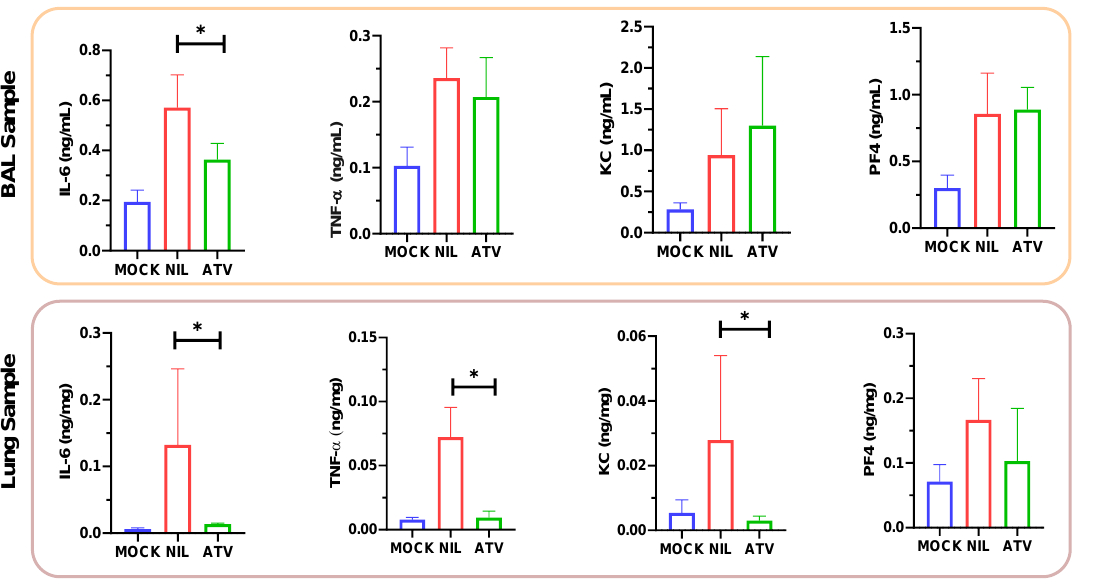
Figure 5. The proinflammatory content in terms of cytokines IL-6, TNF- α , KC and PF4 in BAL and lung samples. * p < 0.05.